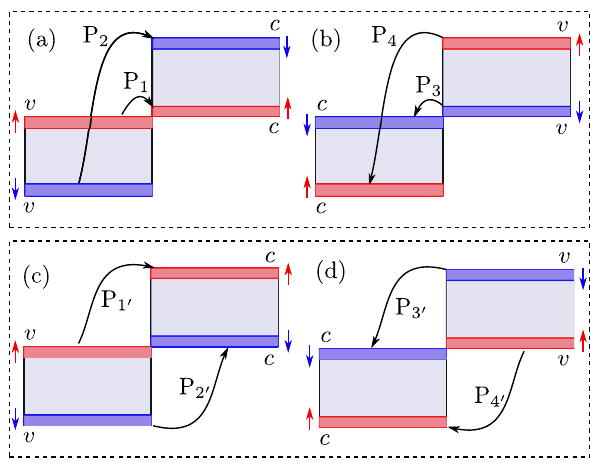
Figure 5: The schematic model of electron excitation processes: (a) and (b) for Junction C6; (c) and (d) for Junction C4. The red and blue narrow rectangles indicate the positions of the spin up and spin down edge states, respectively. 𝑣 means valence band while c means conduction band. The bent arrows indicate the possible excitation paths as marked by P ( P ), P ( P ), P ( P ) and P ( P ). For 1 1 ′ 2 2 ′ 3 3 ′ 4 4 ′ example, P means that in Junction C6, electrons are excited from 1 the spin up valence band edge states at the upper edge of the left ribbon to the spin up conduction band edge states at the lower edge of the right